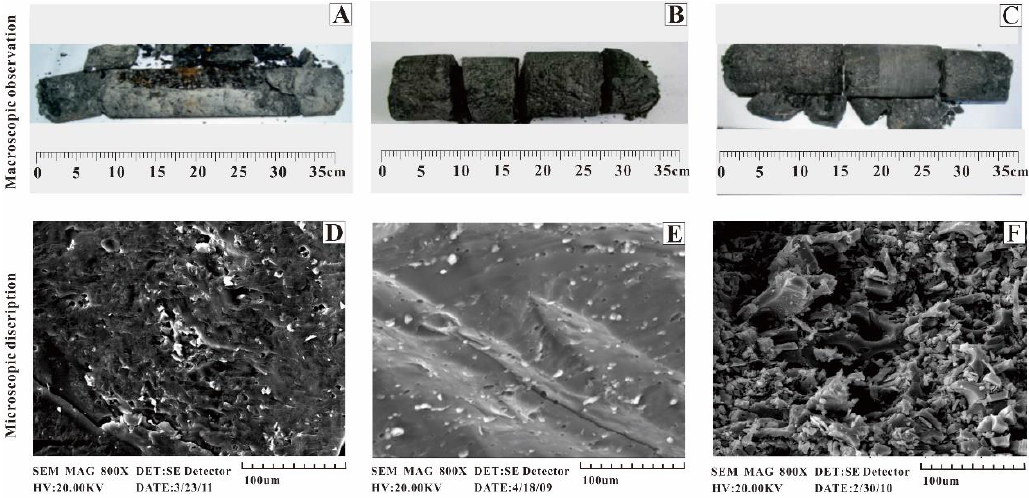
Figure 3. Typical characteristics of coals with different macrolithotypes (( A , D ) bright coal; ( B , E ) semi-bright coal; ( C , F ) semi-dull coal)).